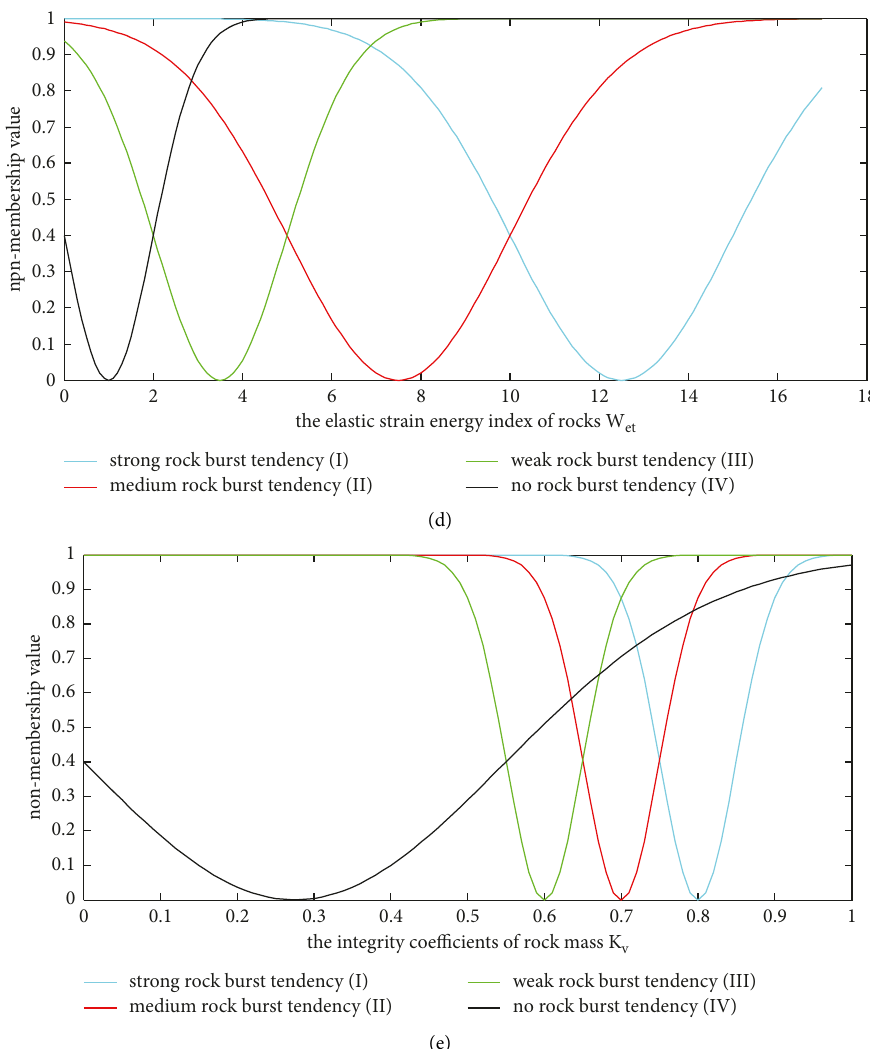
c , (b) strength stress ratio σ c / σ 1 , (c) ratio